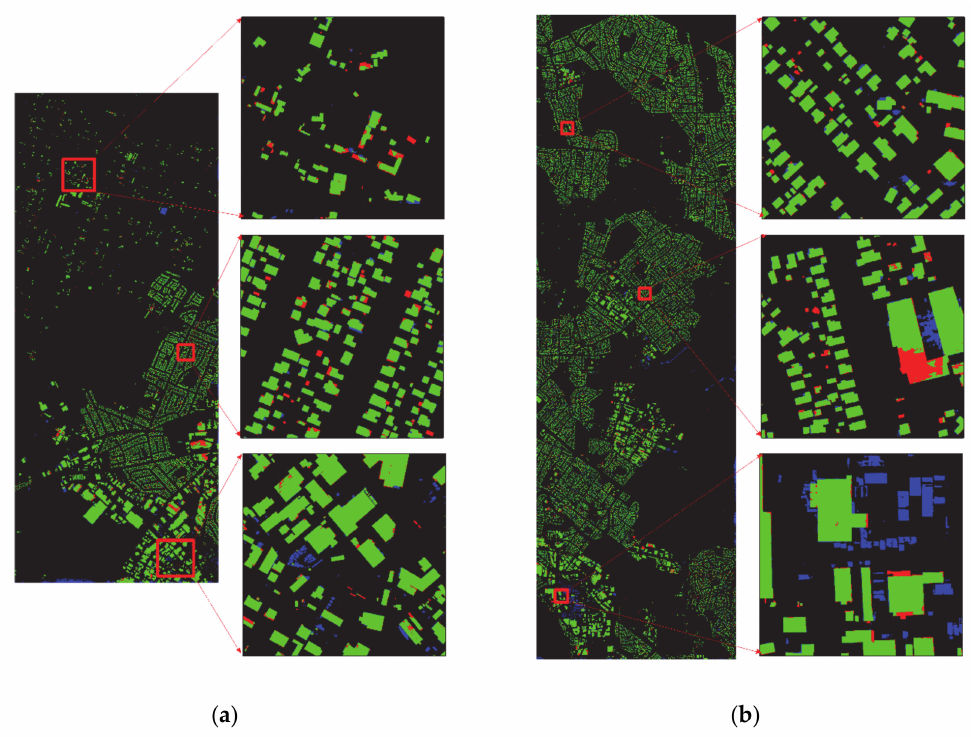
Figure A2. The performance of Deeplabv3+Net with the dice coefficient loss and batch size set to 1 during training process, ( a , b ) show the building extraction result of the Deeplabv3+Net on test A and test B area respectively.